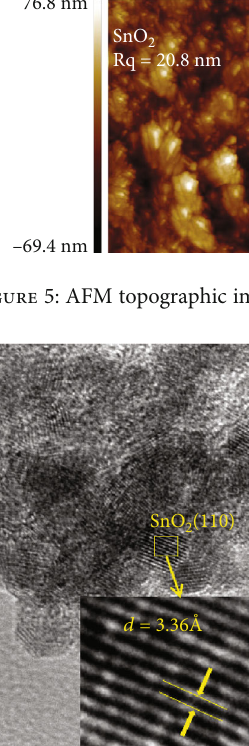
nanoparticles. 2